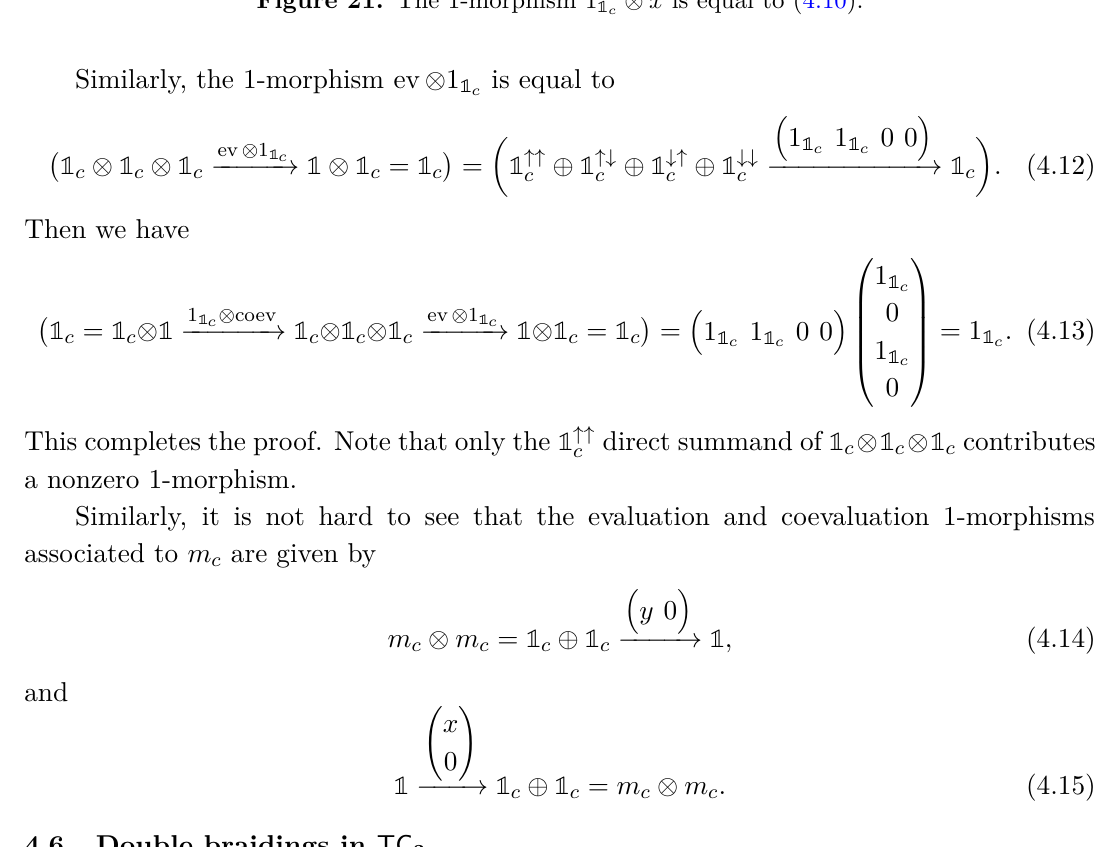
Figure 21. The 1-morphism 1 1